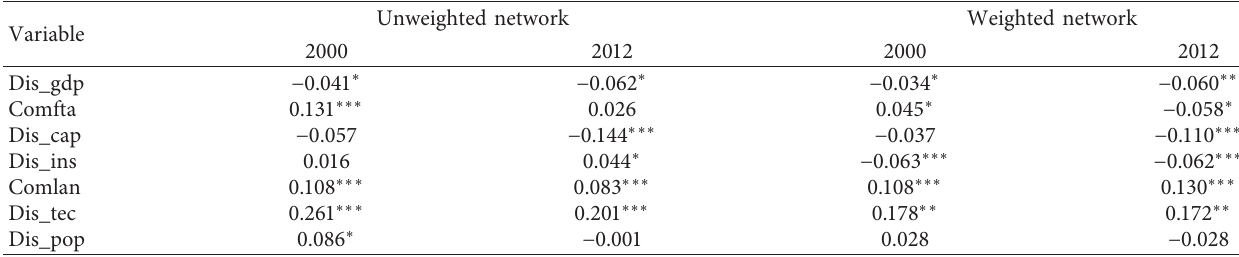
Table 8: QAP regression result of the producer services trade